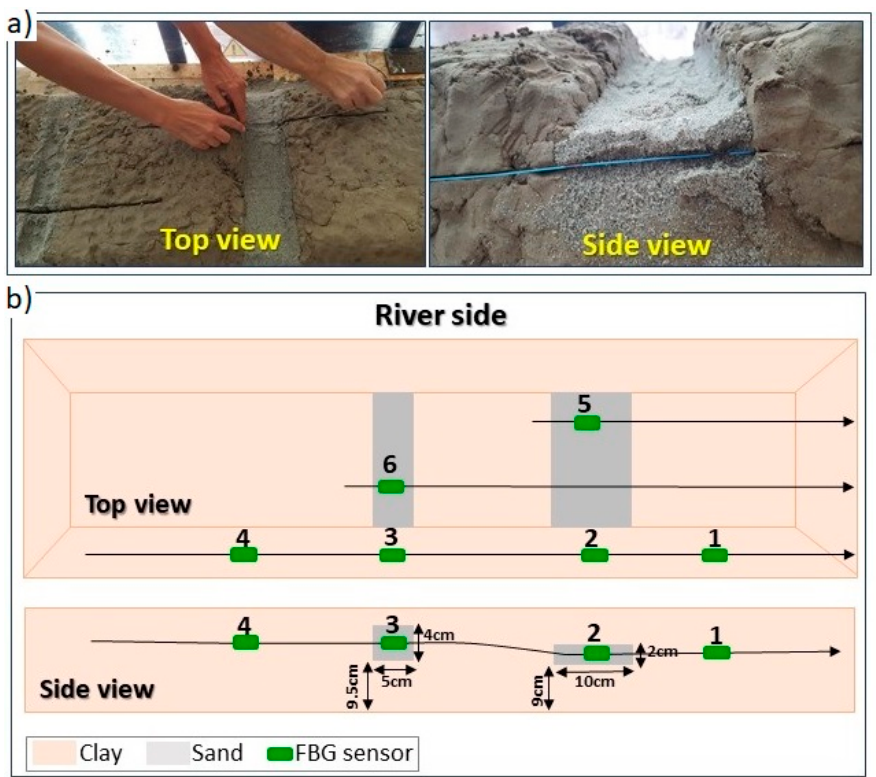
Figure 2. ( a ) Deployment of fiber optic sensors during levee construction: on top of the levee inside sandy seepage zones (left) and at the exit of seepage zones (right). ( b ) Top and side views of the locations of fiber optic sensors in different parts of the levee.